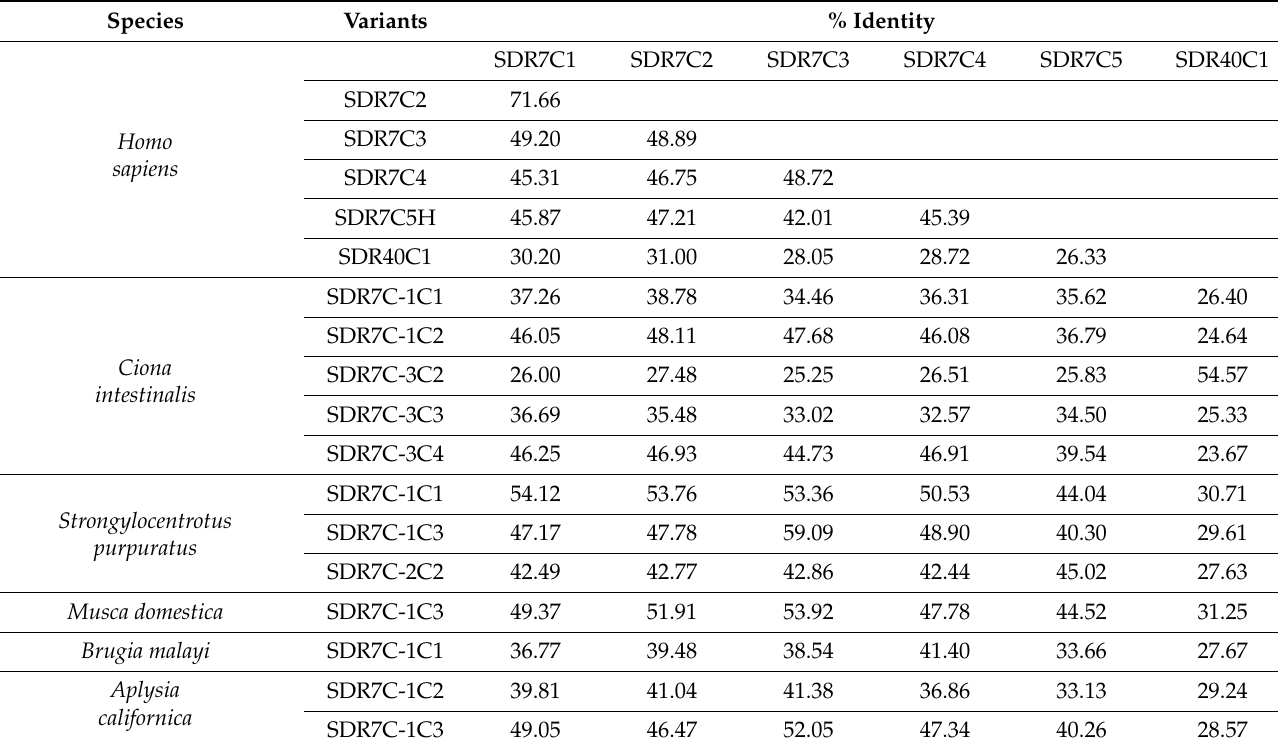
(Table 3), despite relatively low levels of identity with the other human SDR7C variants (26.3–31%, Table 4). Presumably, the low sequence homology prevented a correct assign- ment of the SDR40C1 variant into the SDR7C family by HMM-based clustering models [3]. Conversely, parsimony analyses based on the splicing-phase structure (Online resources 5: Figure S37) cluster the SDR40C1 variant within vertebrate and invertebrate orthologs of the SDR7C family with bootstrap support up to 92%. Proteins belonging to different super- families, which may have identities as low as 4% and whose homology can only be inferred from a similar 3D structure and function, may share splicing patterns [26]. Table 4. Percent identity values of the human SDR7C family and SDR40C1 protein variants and of their invertebrate